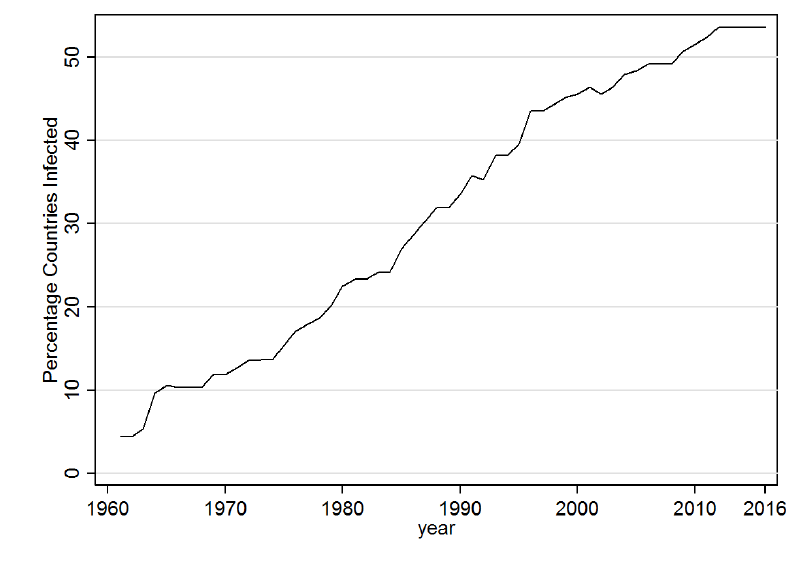
Figure 2. Black Sigatoka Detected-% Countries. Note: This figure shows the percent of banana producing countries that have been